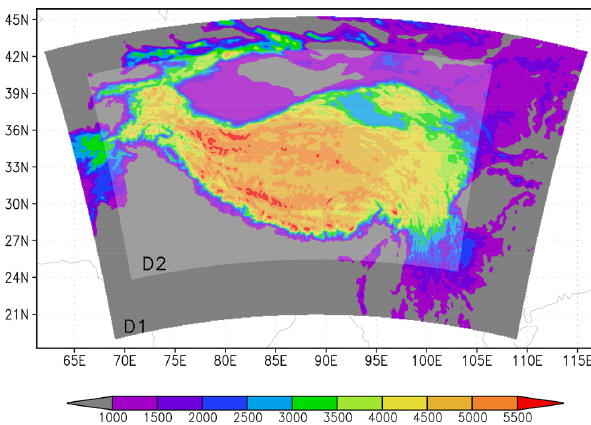
Fig. 1. Nested model domains and topography (m) of the simula- tion.